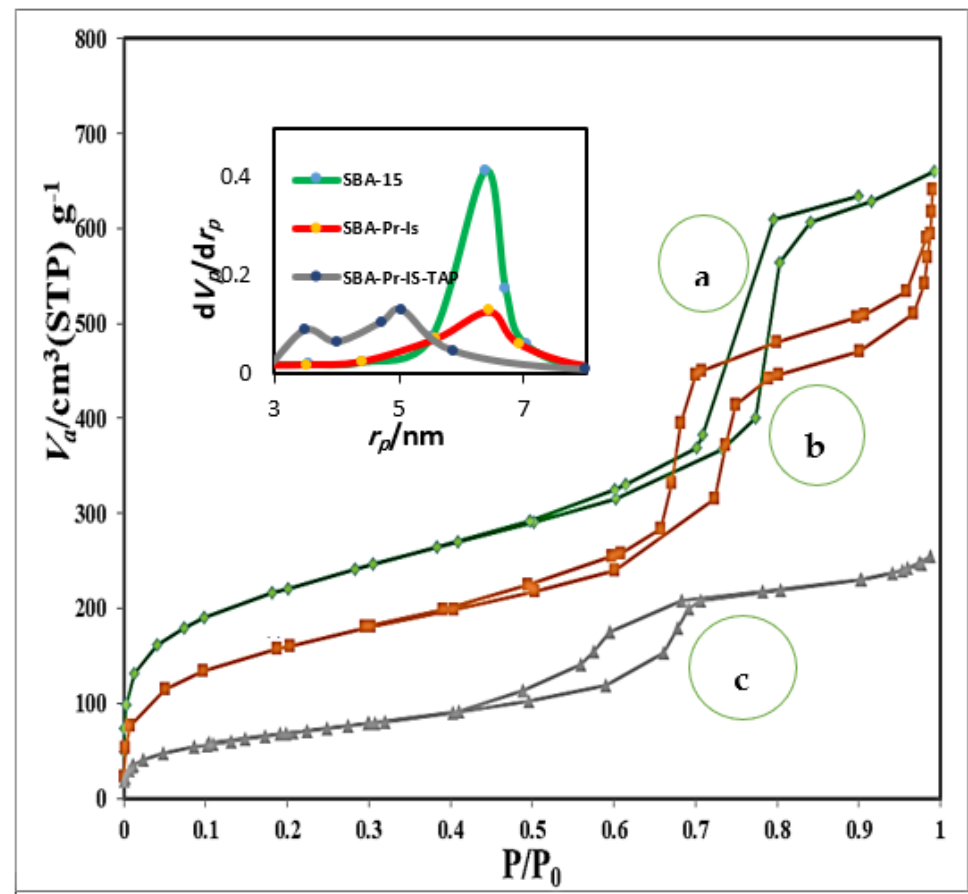
Figure 5. Nitrogen adsorption-desorption isotherms of ( a ) SBA-15, ( b ) SBA-Pr-Is, and ( c ) SBA-Pr- Is-TAP.